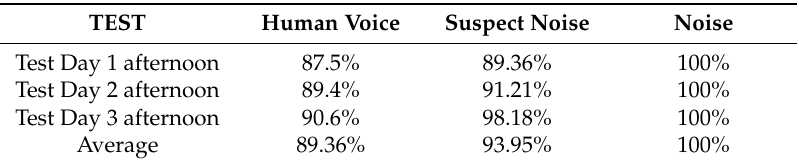
Table 3. Evaluation of